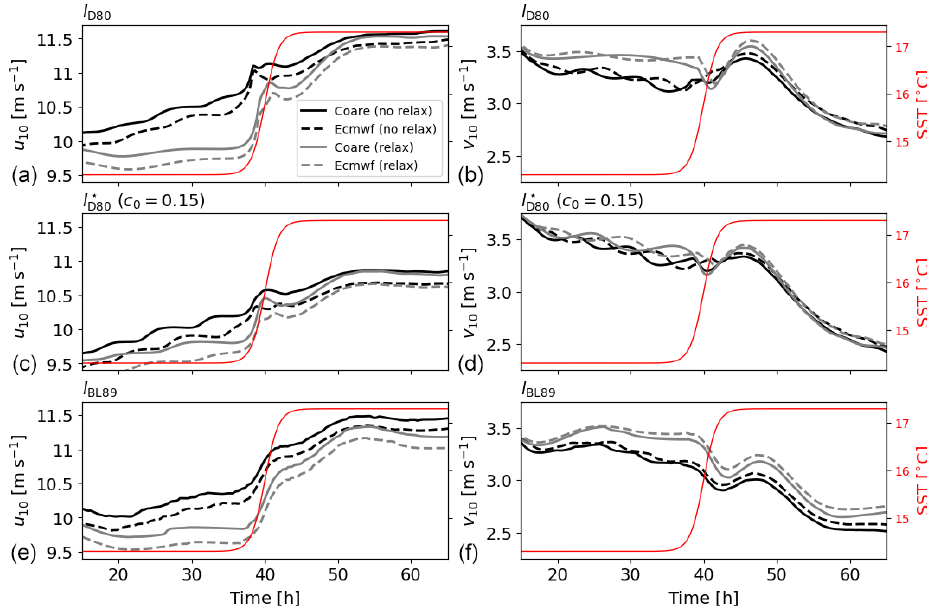
Figure 9. Temporal evolution of the zonal (a, c, e) and meridional (b, d, f) components of 10m atmospheric winds for ABL1d simulations of an air column crossing an SST front. The temporal evolution of SST (solid red lines) is also shown. For each panel the results from four different simulations are shown: with COARE bulk formulation (solid lines) or IFS bulk formulation (dashed lines), with Newtonian relaxation on temperature such that λ min s = 1 and λ max s = 1 (gray lines) or no relaxation (black lines). Panels (a, b) are obtained from 48 [ h ] 6 [ h ] simulations performed with l D80 mixing length, (c, d) with l (cid:63) ( c 0 = 0 . 15), and (e, f) l BL89 . D80